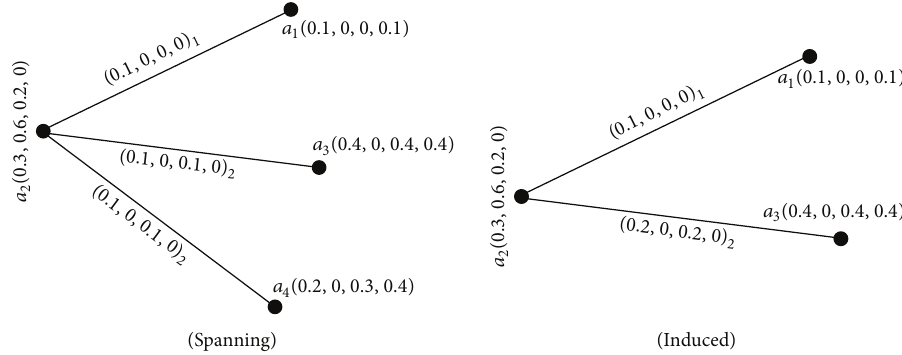
Figure 2: Four-polar fuzzy subgraph structures.